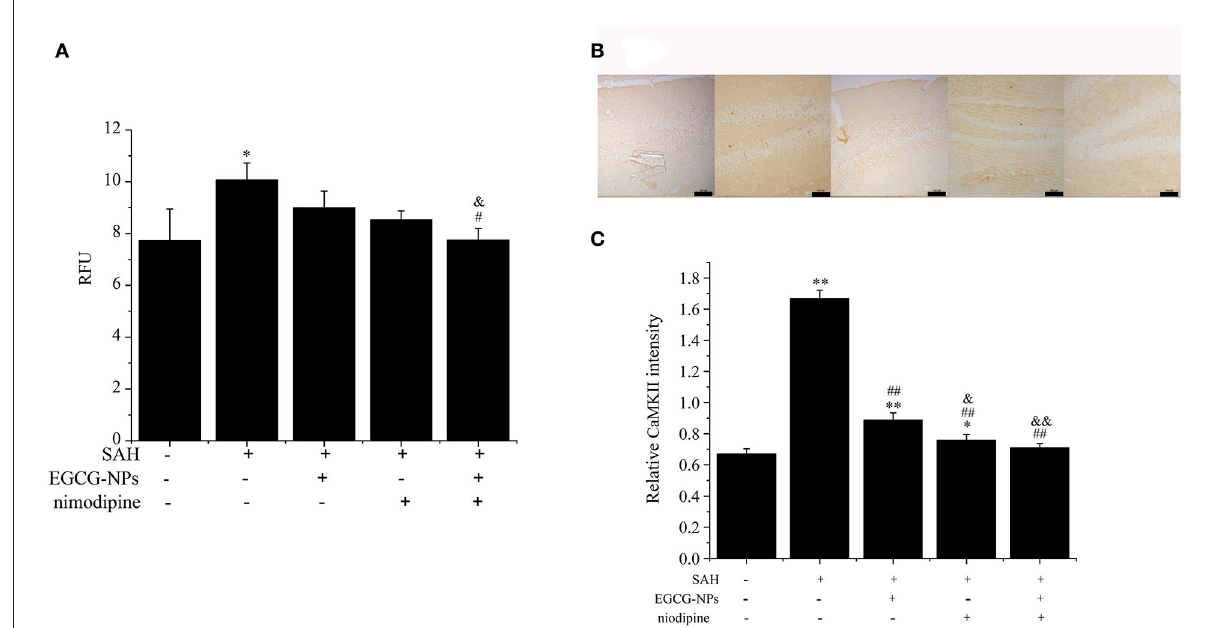
FIGURE6 Cotreatment of EGCG-NPs and nimodipine attenuated the intracellular Ca 2 + levels and the expression of CaMKII after SAH. EGCG-NPs + nimodipine significantly attenuated the Ca 2 + overloading after SAH (A) . Fluorescence was monitored at a measurement frequency of 10s using a fluorescence plate reader. Cotreatment of EGCG-NPs and nimodipine inhibited the expression of CaMKII (B) , scale bar = 100 µ m. Quantification of the CaMKII level by densitometry (C) . Scale bar = 100 µ m. * P < 0.05 vs. Sham, ** P < 0.01 vs. Sham; # P < 0.05 vs. SAH,